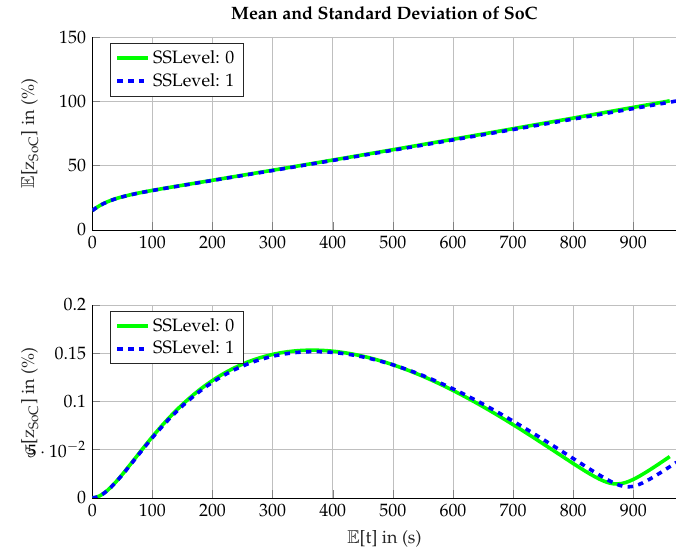
Figure 7. Mean and standard deviation value for state-of-charge over time for